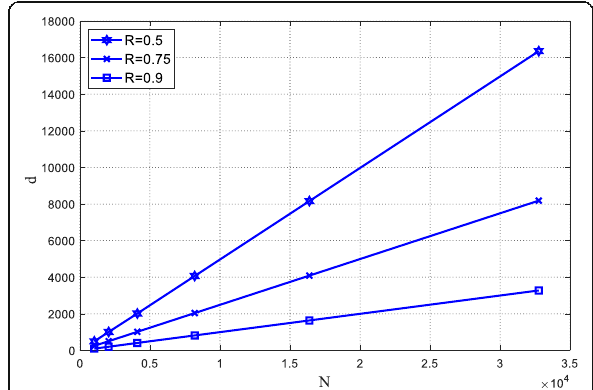
Fig. 12 Variation trend of d with code length log 2 N for a different R : The variation trend of d with code length N . And it shows a semi- logarithmic relationship. At different code rates, d increases with the code length N for R = 0.5, 0.75, and 0.9, respectively